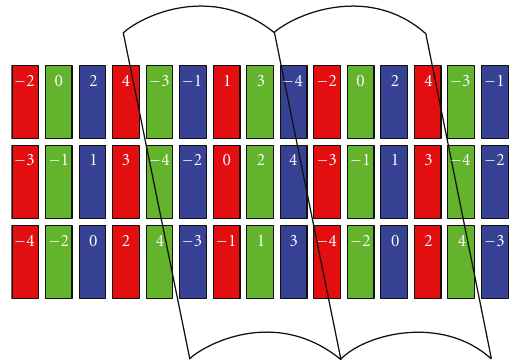
Figure 3: The cylindrical lenses depict every subpixel in a di ff erent view. The numbers in the subpixels indicate in which view they are visible.